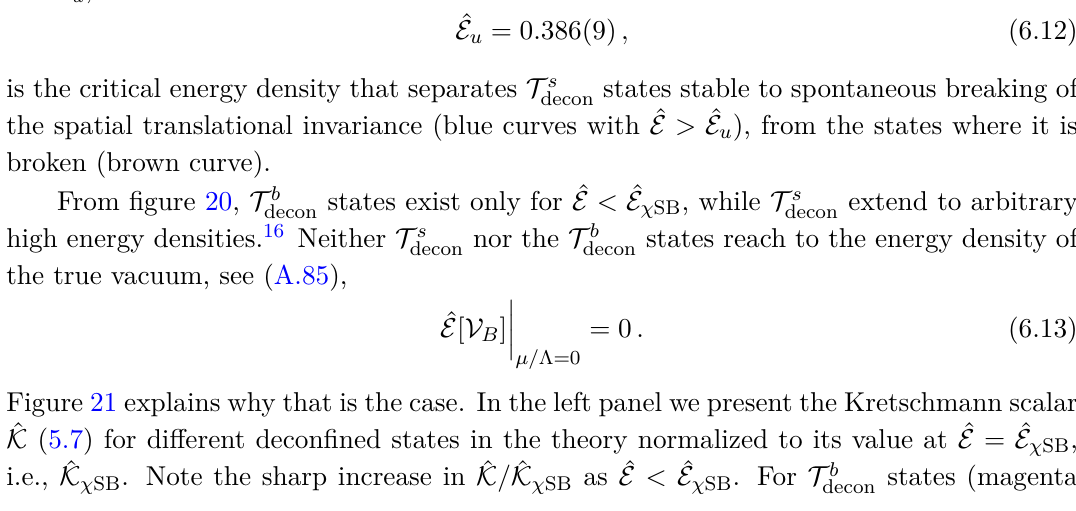
, see (5.1), for different deconfined states in E (red) for the of the E χ SB (brown) for the onset of the spontaneous breaking E u s decon T